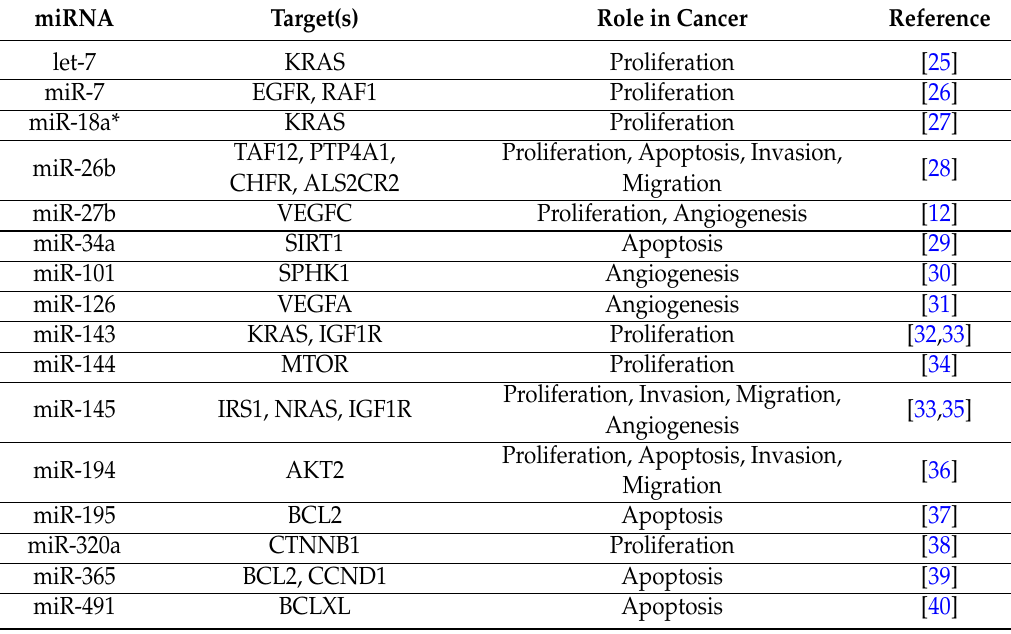
Table 2. Tumor-suppressive miRNAs in